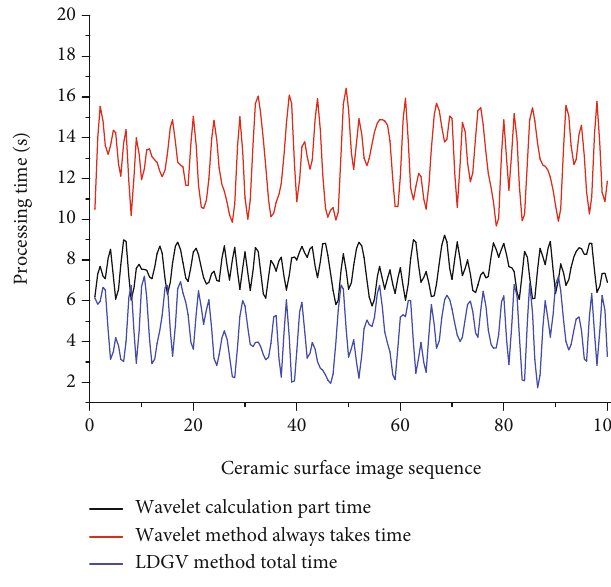
Figure 3: Algorithm running